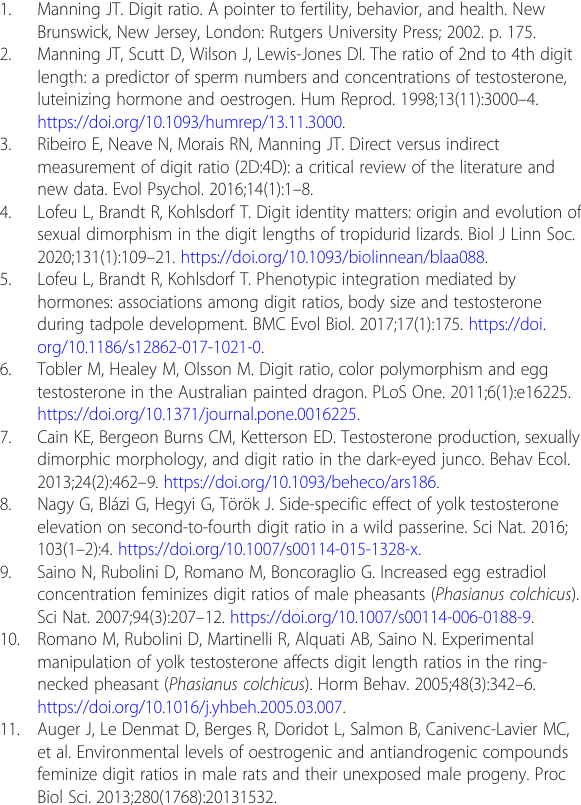
Additional file 1: Figure S1. Age structure of the common toad Bufo bufo based on the second dataset containing only individuals from site 2, with individuals after 3, 4, 5, 6, 7, or 8 hibernations (black columns – male; white columns – female). Table S1. Values of the intraclass correlation coefficient (ICC) calculated for 30 randomly selected individuals for which the digit measurements were carried out twice (D2 - D5, digit